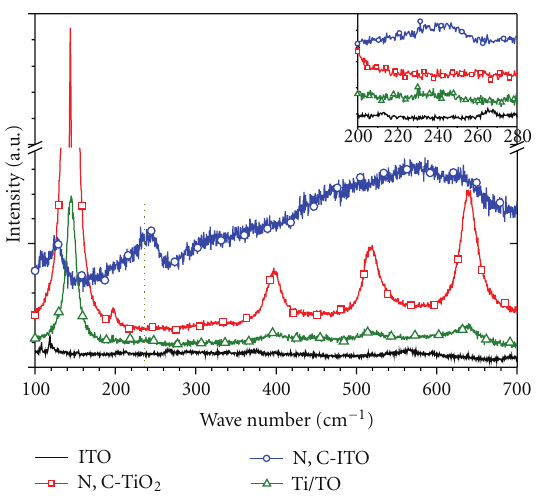
Figure 2: Raman spectra of the composite Ti/TO electrode along with N,C-TiO 2 , N,C-ITO, and ITO film